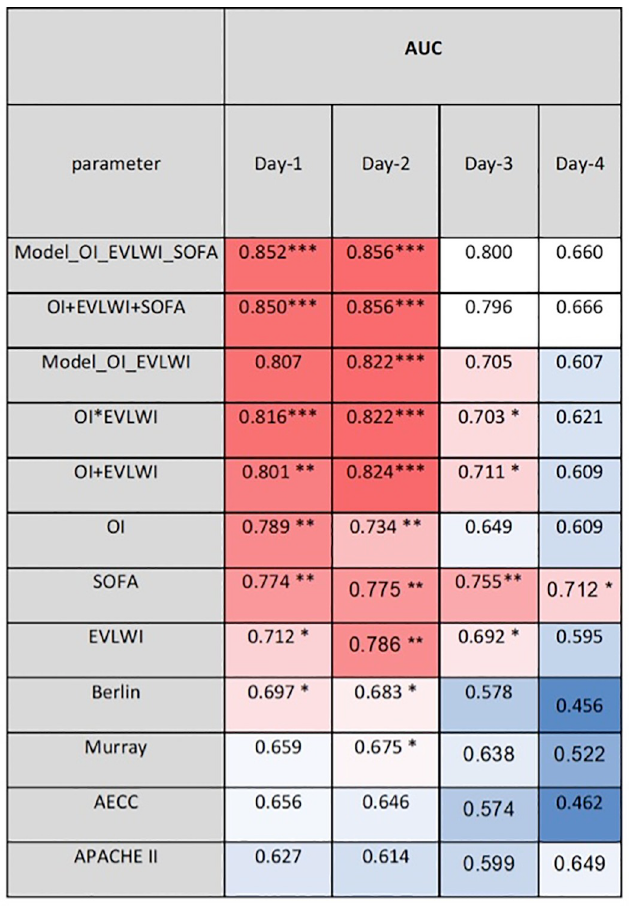
Fig 5. Thermoplot illustrating ROC-AUCs of single parameters, scores and combined models within four days after intubation in patients with PiCCO-monitoring. Y-axis ranges from 0.5 (worthless for prediction; intense blue) to 1.0 and 0.0 (best prediction; intense red). AUC: area under the curve.OI: oxygenation index; EVLWI: Extra-vascular Lung Water Index; AECC: American European Consensus Conference; Murray_mod: modified Murray-score (sum of points without radiological points); AUC: area under the curve. APACHE-II: Acute Physiology And Chronic Health Evaluation; SOFA: Sequential Organ Failure Assessment.